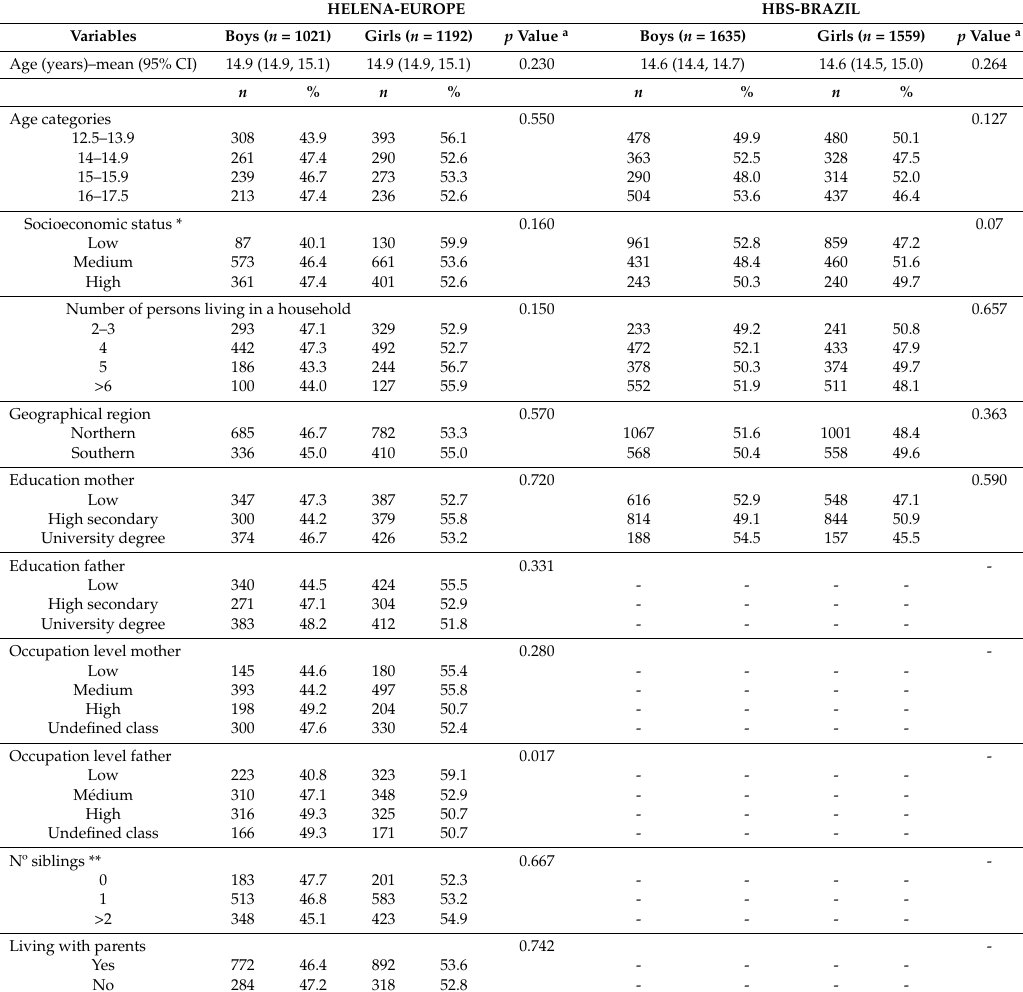
a Gender differences using Person test for categorical variables and t -test for continuous variables. - Information about these variables was not available in HBS-Brazil. Abbreviations: 95% CI (confidence interval), HELENA; Health, Lifestyle in Europe by Nutrition in Adolescence, HBS; Household Budget Survey. * Based upon Family Affluence Scale (FAS) in HELENA versus total family income in the Brazilian study. ** Number of brothers and